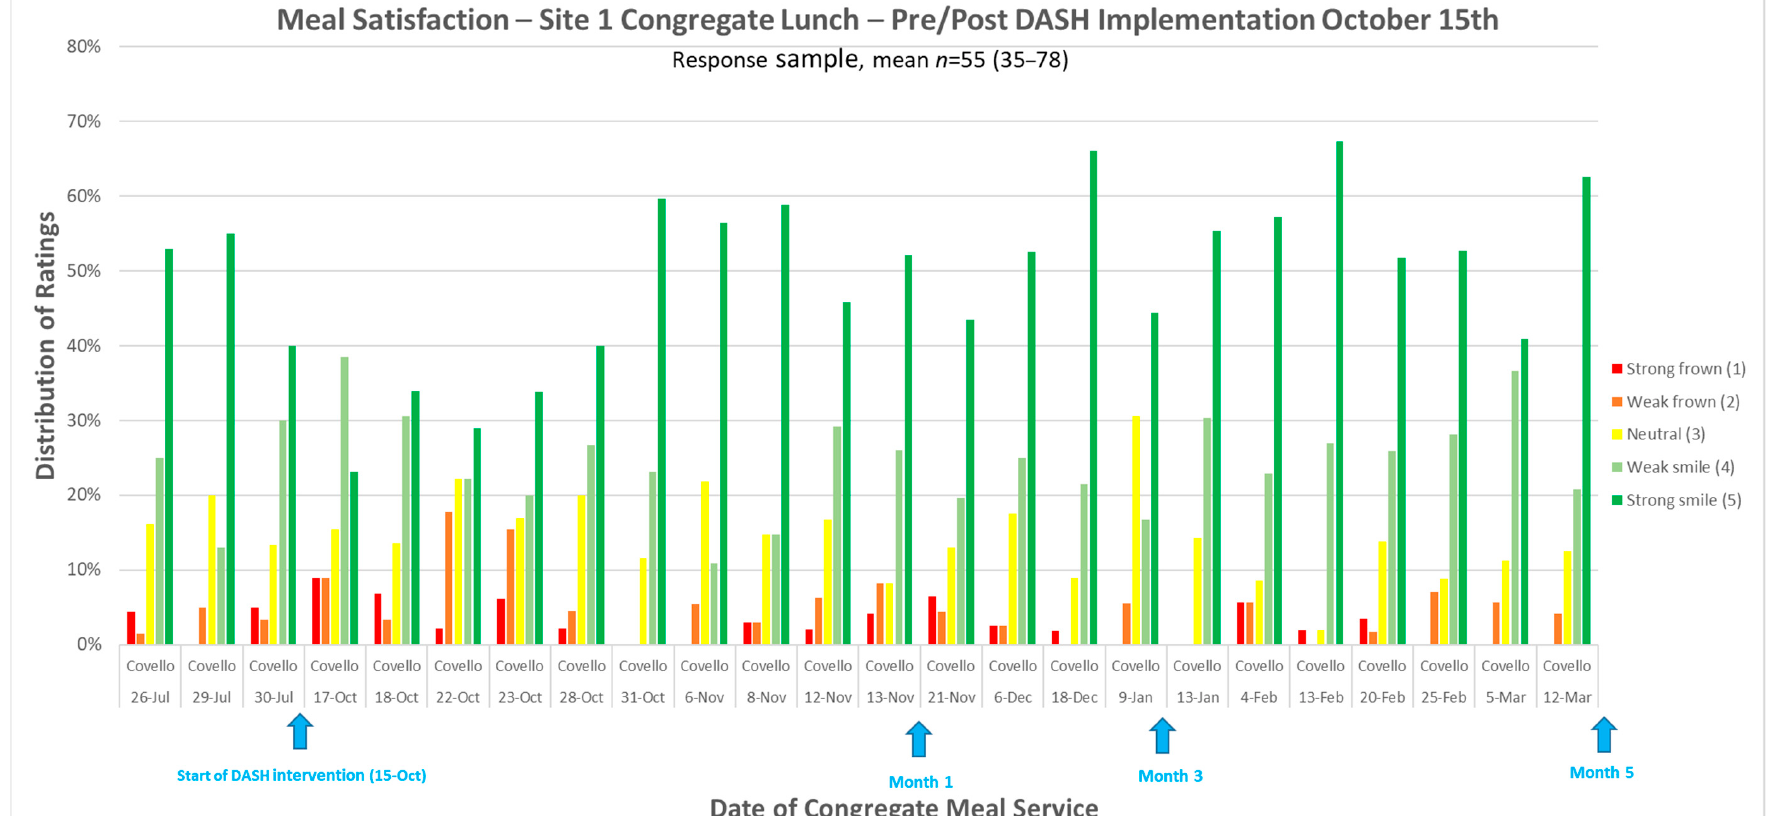
Figure 2. Meal Satisfaction as a measure of acceptability. The colored bars show client responses on Smiley Likert Cards. Meal satisfaction was assessed in July prior to the start of the DASH-aligned menus in October. Blue arrows mark important dates in the intervention- start, month 1, month 3, and month 5.